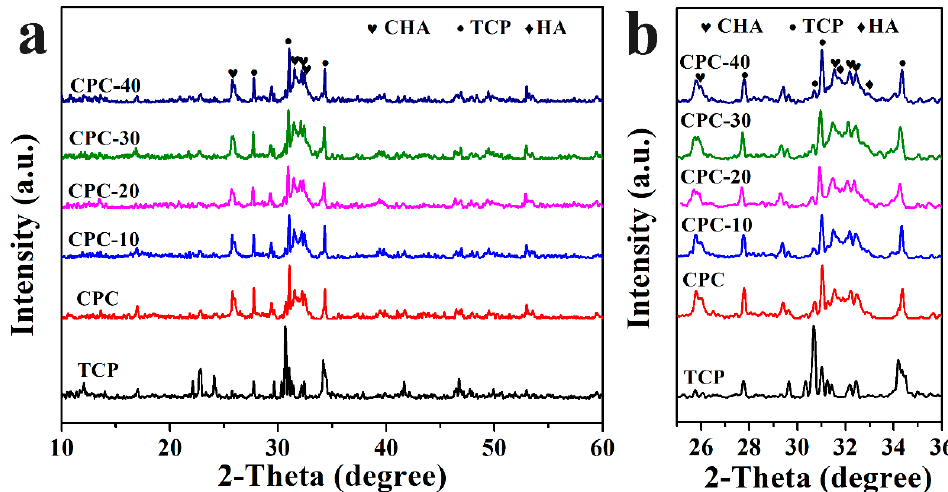
Figure 10. XRD pattern of sample CPC and PLGA-PEG-PLGA/CPCs after immersion for three days ( a ) and enlarged image from 25 to 36 degrees ( b ).